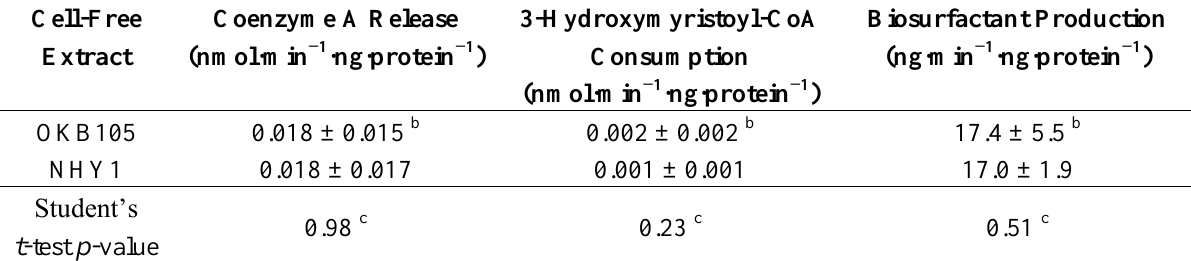
Table 1. Surfactin synthase activity in OKB105 and NHY1 cell-free extracts in the presence of 3-hydroxymyristoyl-CoA a